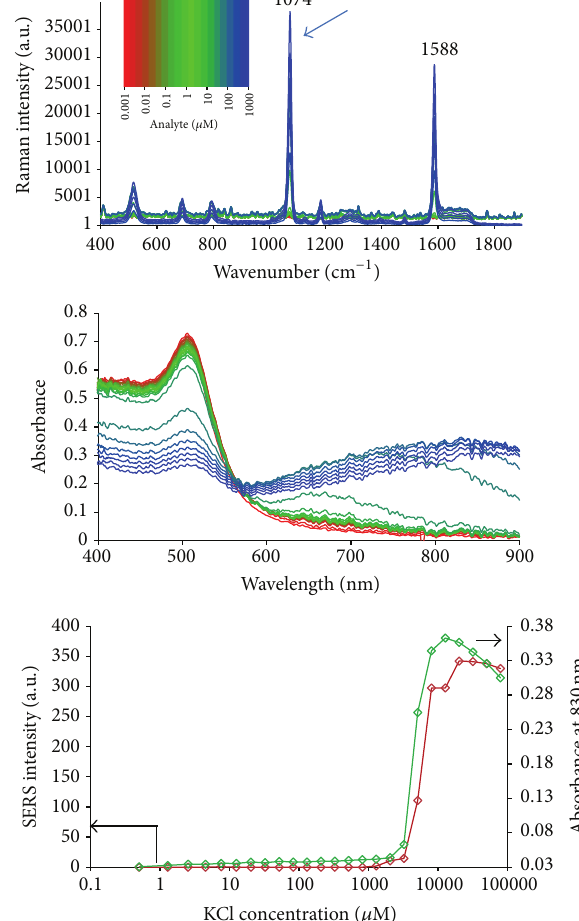
Figure 7: In this figure nanoparticle solutions are pretreated with MBA (1.7 𝜇 M total concentration) and then titrated with KCl. The top panel is Raman scattering spectra of nanoparticles with preadsorbed MBA. The middle panel shows concurrently acquired extinction spectra. Concentrations are color-coded concentration as above, but now indicating KCl ranging from 1 𝜇 M (red) to 100mM (blue). The figure at the bottom illustrates the variation of integrated Raman intensity (left scale, red diamonds) and aggregate-band extinction (right scale, green diamonds). The blue arrow indicates the band used in SERS intensity